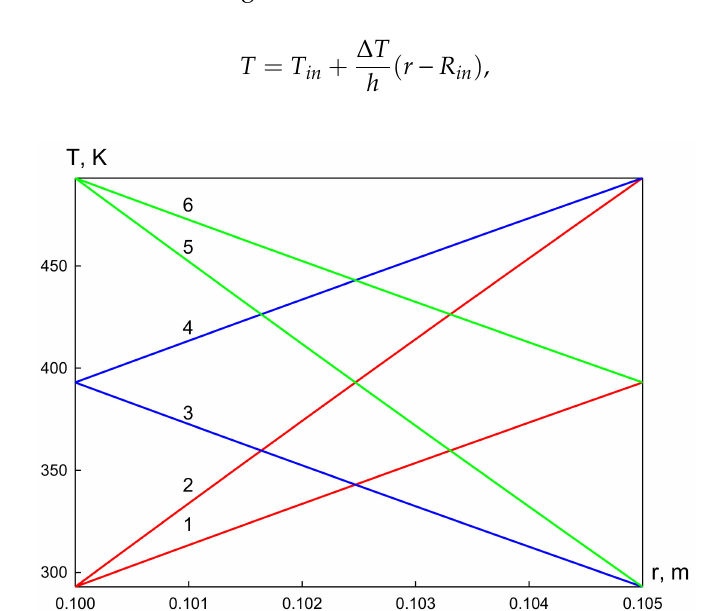
Figure 4. Temperature distribution in the tube wall: radius of the inner wall of the pipe R in = 0.1 m, radius of the outer wall of the pipe R ex = 0.105 m. The red curves (1 and 2) correspond to an inner wall temperature of 293 K. On curve 1 the outer wall temperature is 393 K; on curve 2 it is 493 K. The blue curves (3 and 4) correspond to an inner wall temperature of 393 K. On curve 3 the outer wall temperature is 293 K; on curve 4 it is 493 K. The green curves (5 and 6) correspond to an inner wall temperature of 493 K. On curve 5 the outer wall temperature is 293 K; on curve 6 it is 493